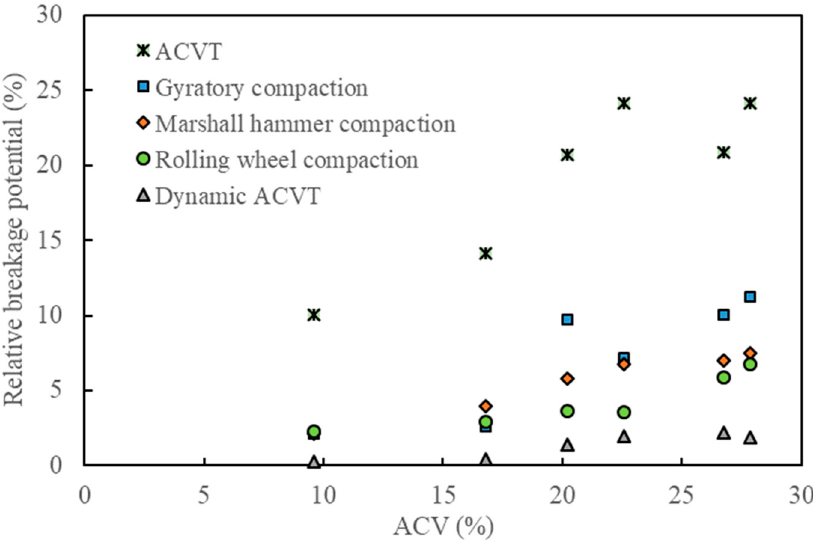
Figure 14. Effect of ACV on the relative breakage potential under various loading methods.